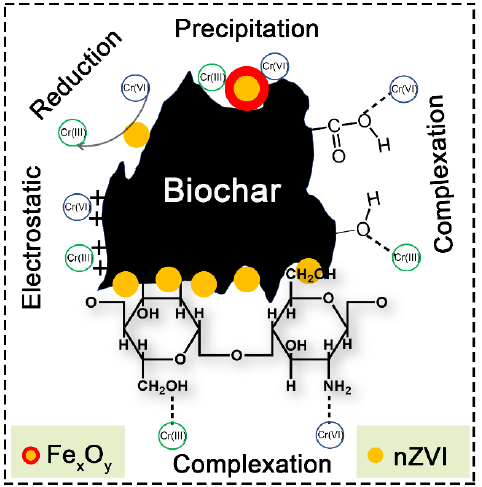
Figure 8. Mechanisms of Cr(VI) sorption by C – nZVI – BC.